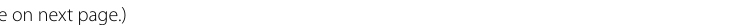
(See figure on next page.) Fig. 7 Viral accumulation and induction of immune responses by SMV NB and SMV GZL in soybean and N. benthamiana . a Symptoms on systemic (non-inoculated) leaves of Dongnong 51 plants at 15 dpi. b RNA levels of SMV NB and SMV GZL in infected plants as determined by RT-qPCR. Data are shown as mean SD of three biological replicates. ** P < 0.01, Student’s t tests. c Immunoblots showing levels of SMV coat protein (CP) levels ± in plants mock-inoculated or inoculated with SMV NB /SMV GZL . Coomassie brilliant blue (CBB) staining of the same extracts shows equal loading. d Transcript levels of GmNPR1 and GmNPR2 in soybean plants infected with SMV NB or SMV GZL as determined by RT-qPCR. Average SMV GZL value equal to 100. e Levels of endogenous salicylic acid (SA) in mock and SMV-infected soybean plants at 15 dpi. Data are shown as mean SD of three ± biological replicates. ** P < 0.01, Student’s t tests. f Transcript levels of NbPR1 , NbNPR1 and NbSABP2 in N. benthamiana plants transiently expressing P1 NB or P1 GZL as determined by RT-qPCR. Average P1 GZL value equal to 100. The numbers above the error bars indicate the fold change of gene expression compared with P1 GZL in N. benthamiana (WT) and transgenic N. benthamiana NahG plants. Statistically significant differences indicated by different lowercase letters are analyzed by Student’s t tests ( P < 0.05). Data are shown as mean SD of three biological ±